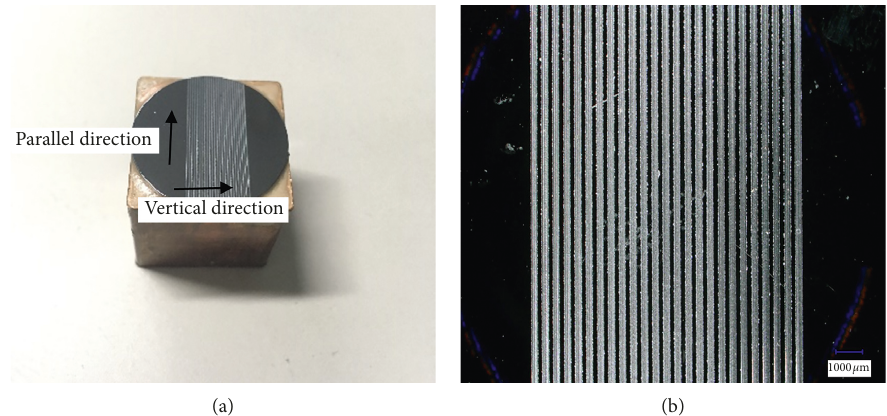
Figure 6: Surface diagram of the processed grating structure: (a) grating structure specimen; (b) grating structure micrograph.